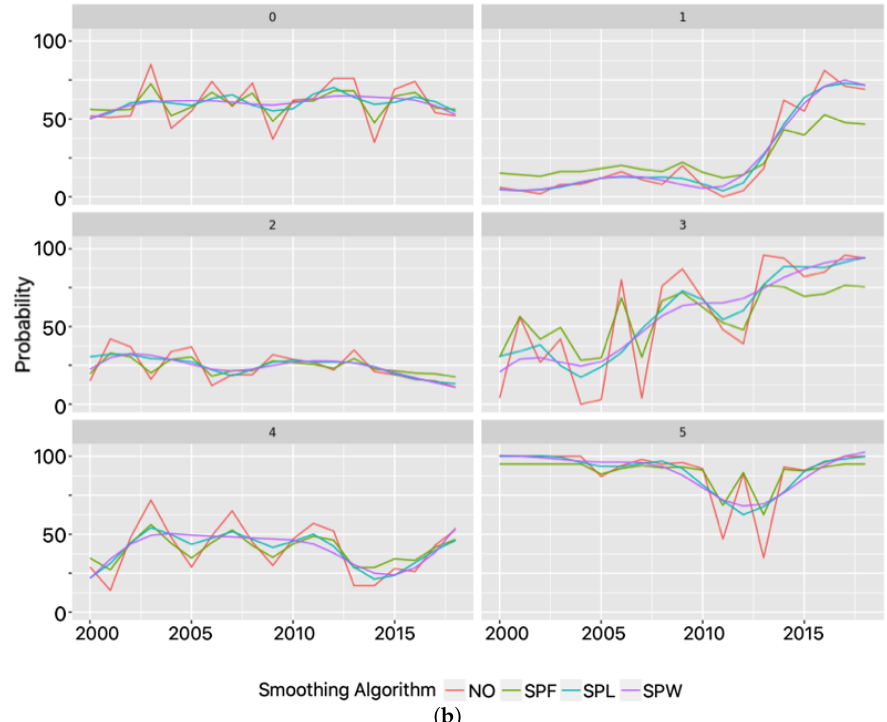
Figure 3. Exploring the nature of smoothing in composites, ( a ) un-smoothed data vs. smoothing applied on composites. NO = No smoothing applied, SCF = Fourier smoothing applied on composite, SCL = Linear-fit smoothing applied on composite, SCW = Whittaker smoothing applied on composite, ( b ) un-smoothed data vs. smoothing applied on primitives. SPF = Fourier smoothing applied on primitive, SPL = Linear-fit smoothing applied on primitive, SPW = Whittaker smoothing applied on